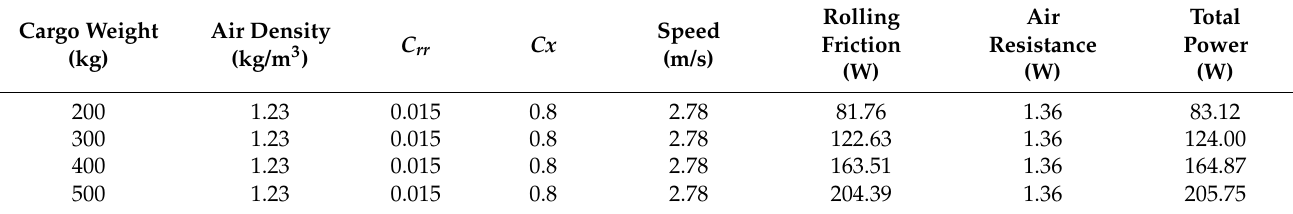
Table 1. Power losses as a function of the vehicle weight.